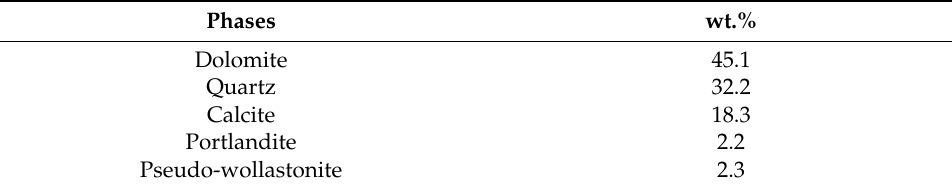
Table 2. Quantification of crystalline phases in concrete dust from XRD.